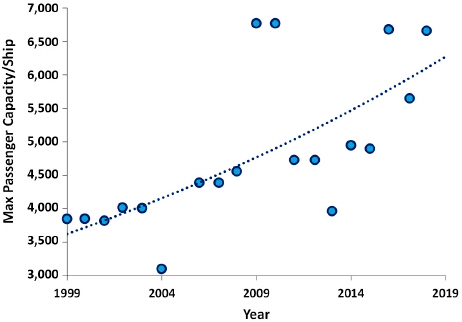
Figure 7. Capacities of largest passenger ships by year.